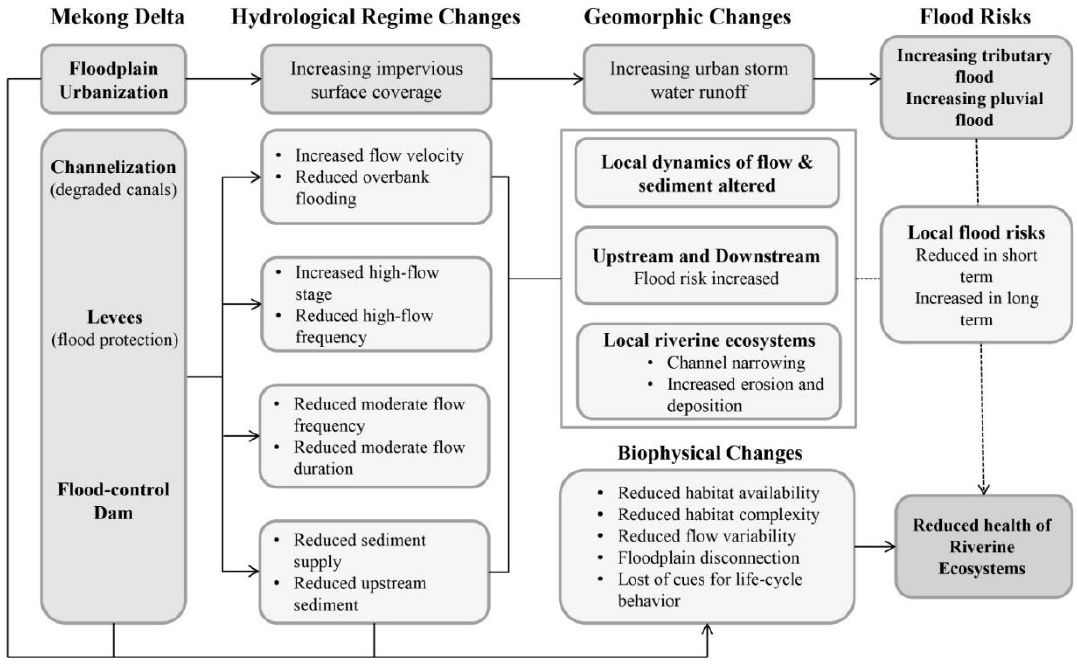
Figure 3. Illustration of the interactions between urbanization, flood control, and flood risk in the urbanized delta at the VMD. Source: Based on [5].